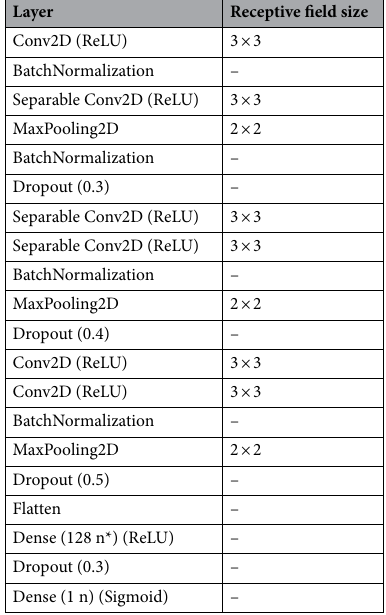
Table 2. The configuration of the proposed model. * n number of